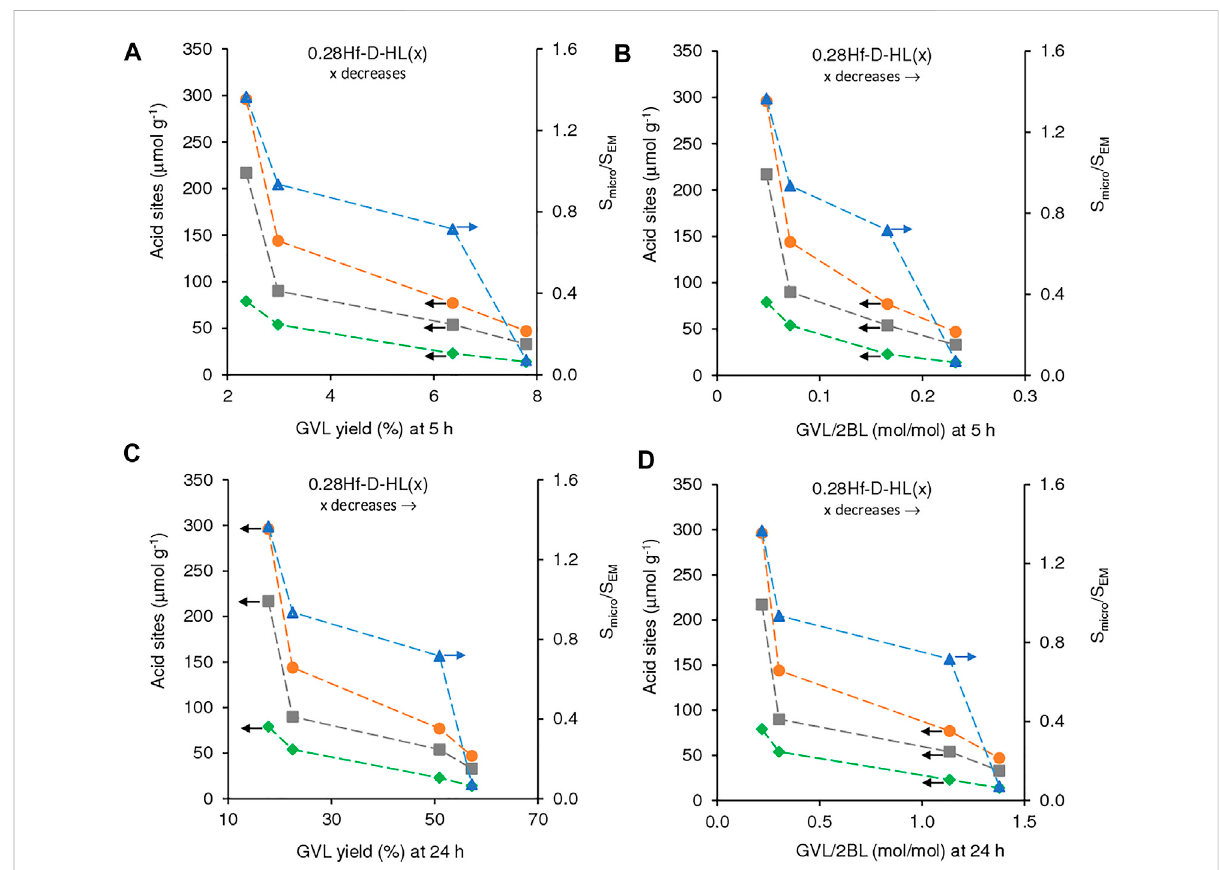
FIGURE 9 (cid:129) In fl uenceoftheamountofacidsites(L( ■ ),B( ◆ )andL+B( ))andS micro /S EM ratio( ▲ ),onGVLyield( (A) , (C) )andGVL/2BLmolarratio( (B) , (D) ),at 5 h( (A) , (B) )and24 h( (C) , (D) )forthereactionofLAinthepresenceof0.28Hf-D-HL(x).Reactionconditions:0.45 MLAin2BuOH,25.5g cat L − 1 ,200 °